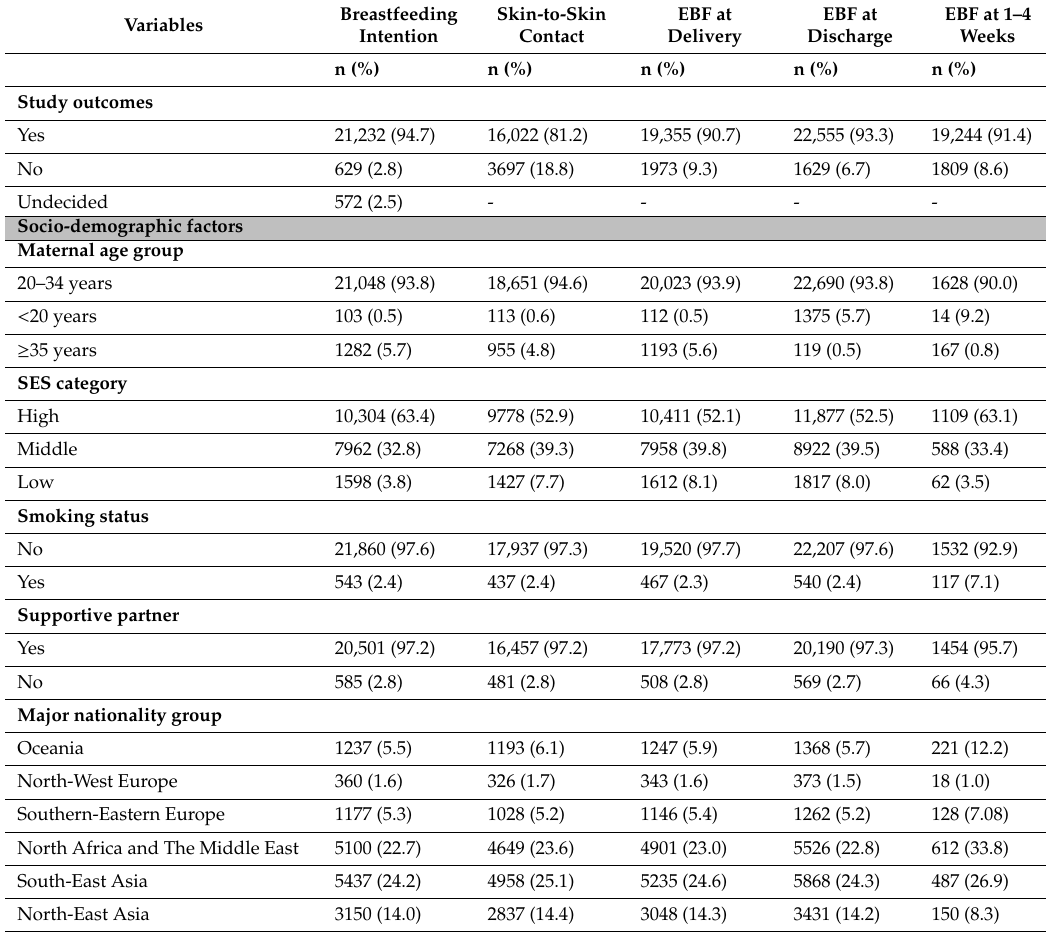
Table 2. Prevalence of breastfeeding among culturally and linguistically diverse (CALD) mothers